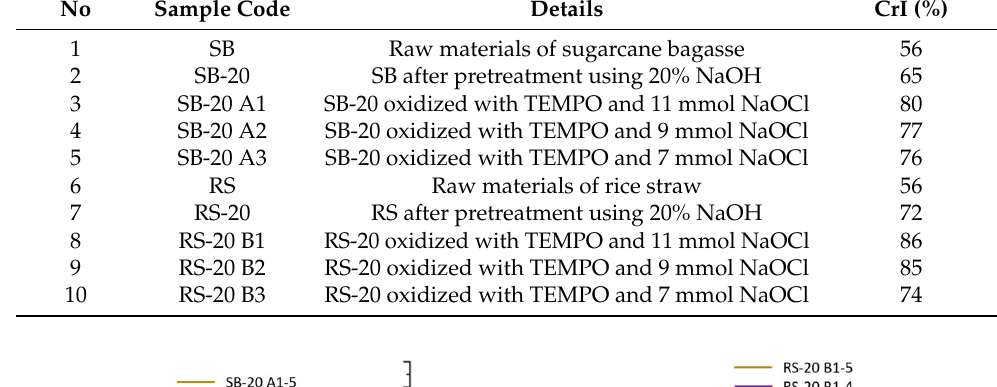
Table 2. Crystallinity of the modified CNC using CTAB from sugarcane bagasse (SB) and rice straw (RS).